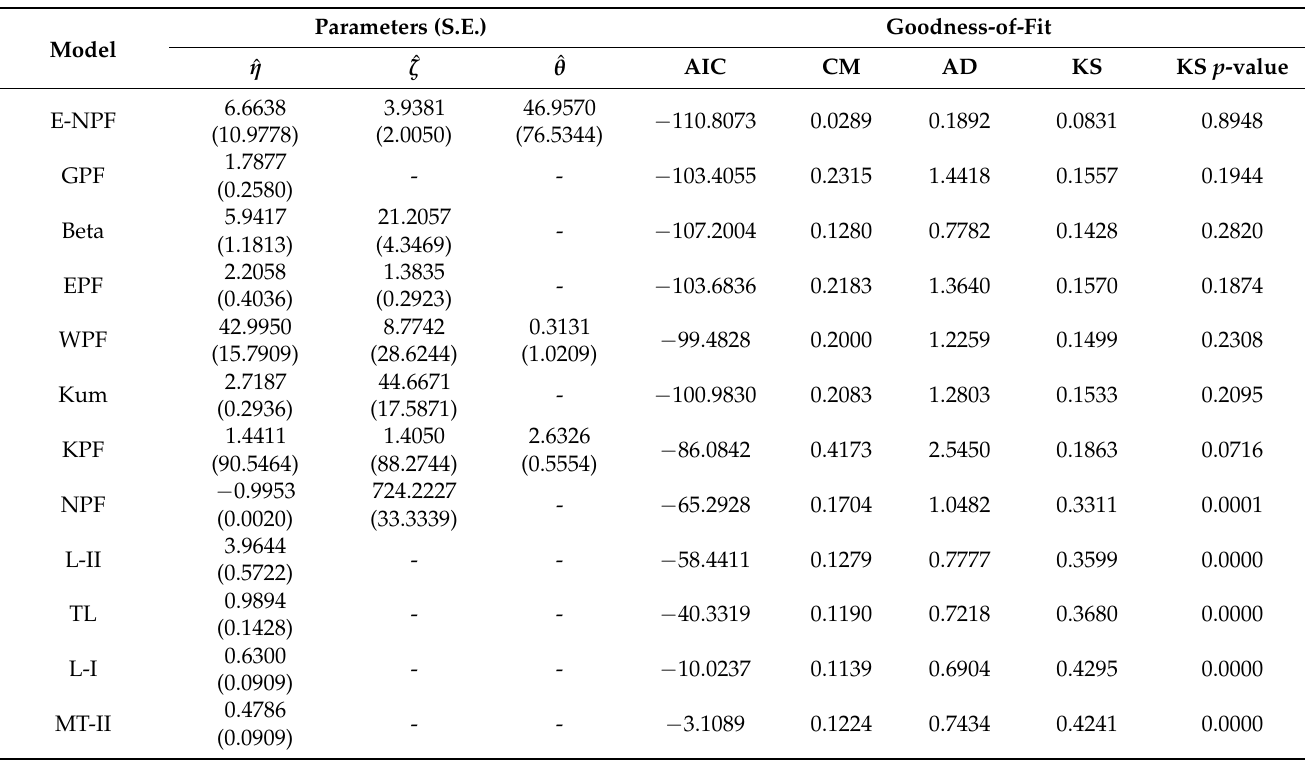
Table 12. Parameter estimates, S.E., and information criterion for rock samples from petroleum reservoir data.